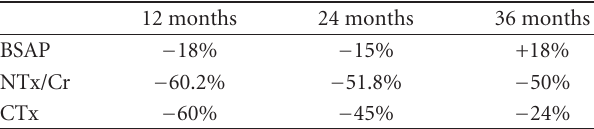
Table 1: E ff ect of 50mg of odanacatib on formation markers and resorption at 12, 24, and 36